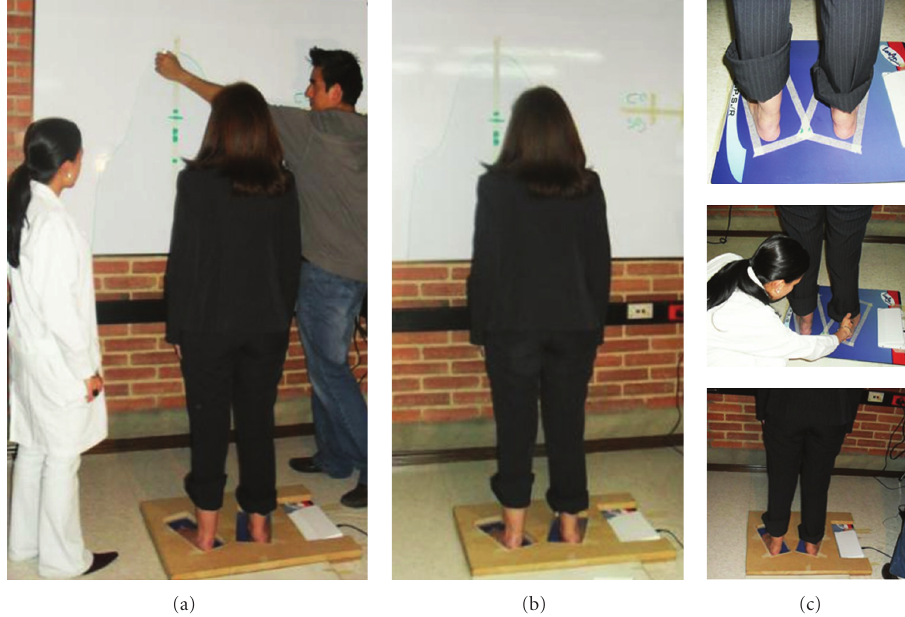
Figure 2: Procedure to assess the repeatability of the Loran Platform using two di ff erent techniques for feet and posture positioning.